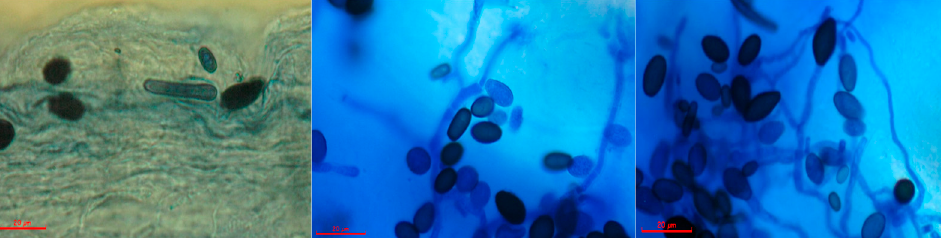
Figure 1. Microscopic characteristics of Thielaviopsis sp. isolated from infected tissue. The photographs show septate hyaline hyphae, microconidia, chlamydospores, and conidiophores. The red bar corresponds to 20 mm.